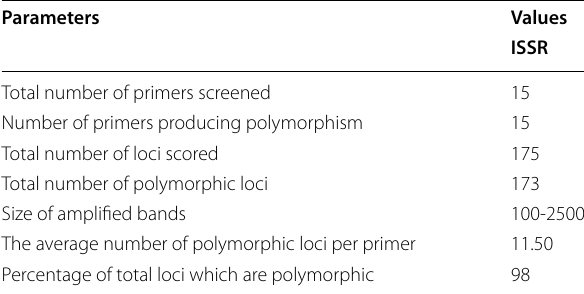
Table 6 Distribution of ISSR amplified fragment in finger millet varieties